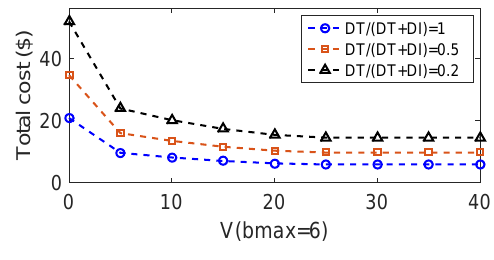
Figure 9. Total cost versus parameter V.